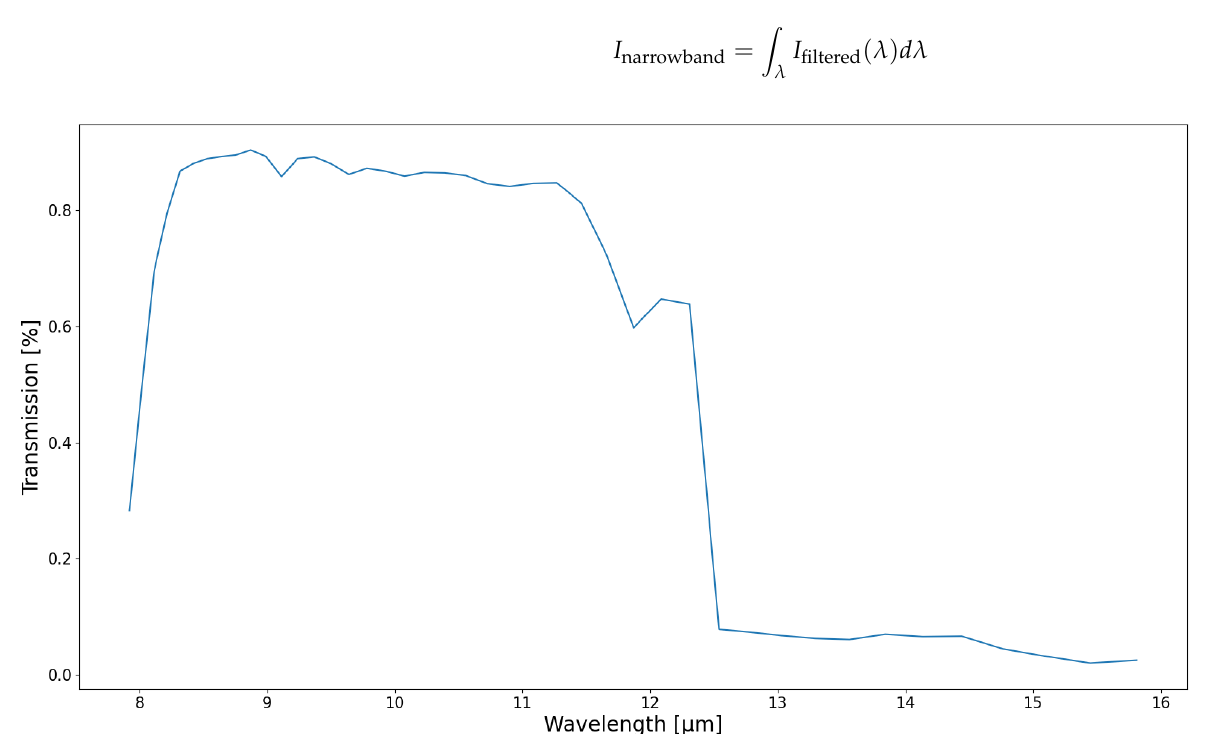
Figure 9. Spectral response of the full optical system, consisting of the germanium lenses and the detector. Considering a blackbody at temperature T , the narrowband irradiance is a function of this temperature.